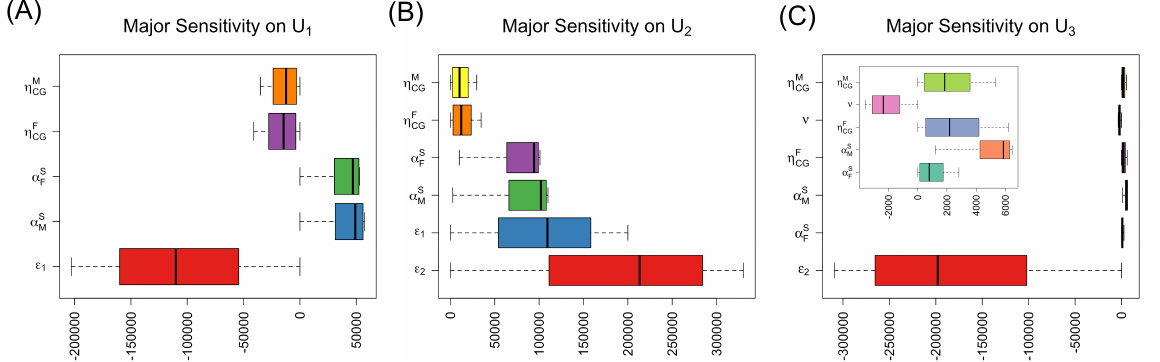
Figure 5. Sensitivity of significant parameters on three married groups, normal-normal marriages ( U 1 ), normal-carrier marriages ( U 2 ), and carrier-carrier marriages ( U 3 ). ( A ) Sensitivity of η M α S , and ε 1 on U 1 . ( B ) Sensitivity of η M M α S , α S and ε 2 on U 3 (the little box is the enlarged plot of η M M F names shown in Table